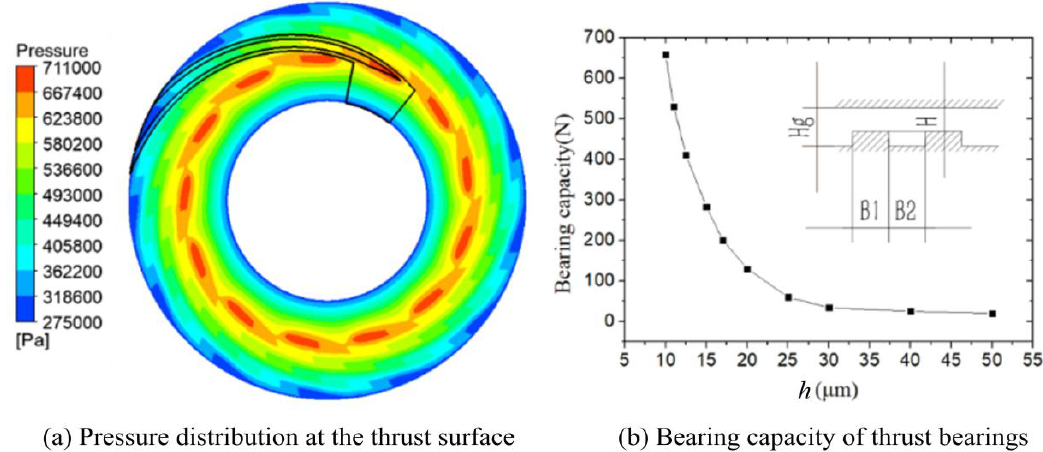
Figure 7. ( a ) Pressure distribution at the thrust surface and ( b ) bearing capacity of thrust hydrodynamic bearings under different film thickness at 7200 rpm. bearings under di ff erent film thickness at 7200